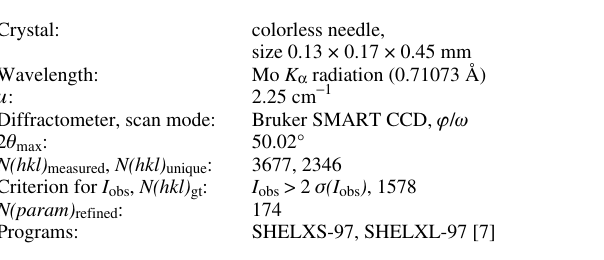
Table 1. Data collection and